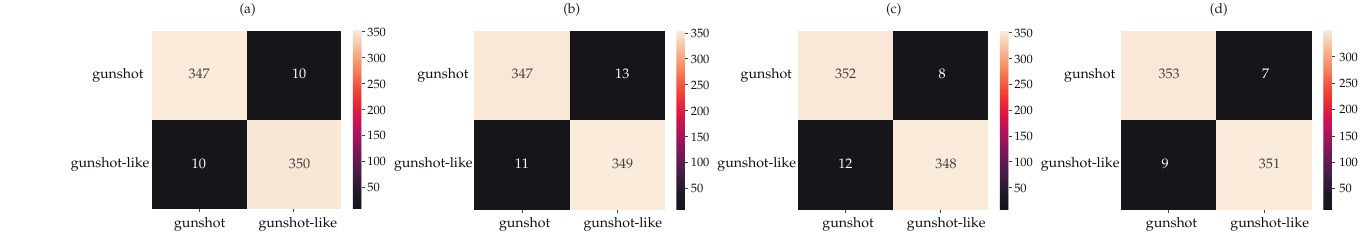
Figure 15. Confusion matrix for ( a ) full dataset, ( b ) 16 common features, ( c ) RF MDI top 20 and, ( d ) SHAP top 20